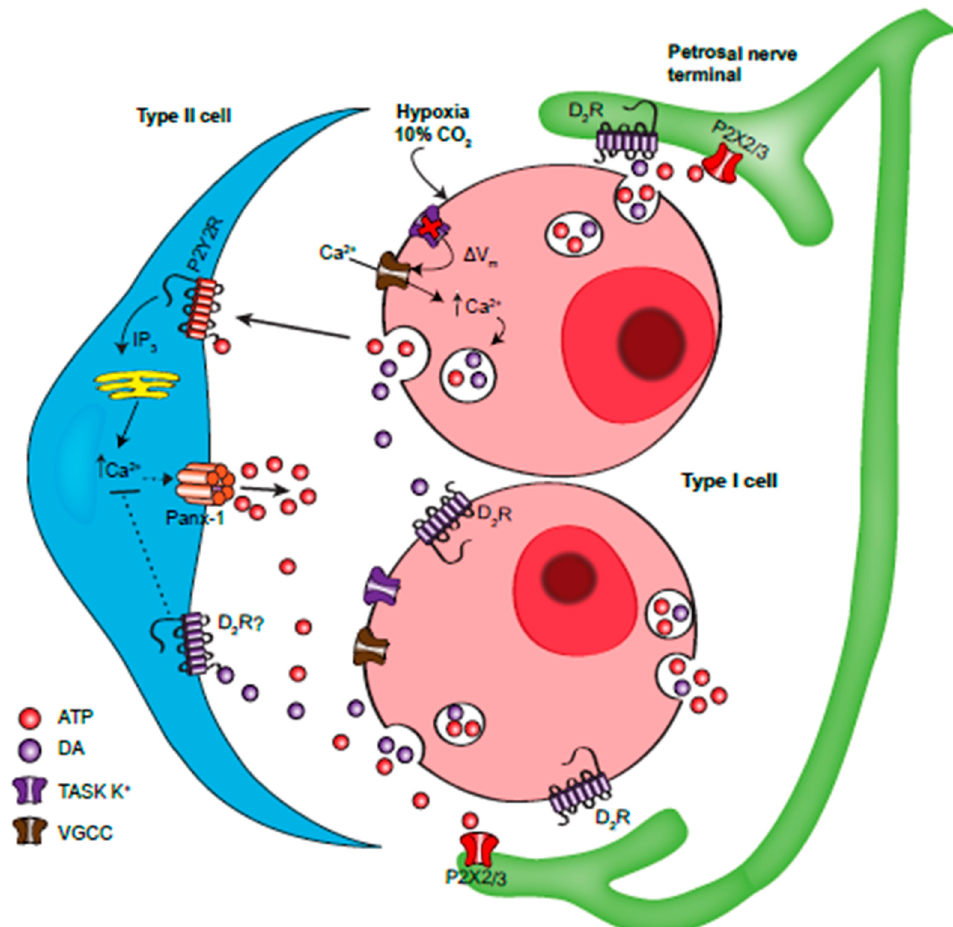
Figure 6. Model of the proposed interactions involving ATP and dopamine at the carotid body ‘tripartite’ synapse. During hypoxia or hypercapnia type I cells depolarize due to inhibition of Two-pore domain, Acid-Sensitive K + (TASK) channels, leading to membrane depolarization, Ca 2 + entry through voltage-gated Ca 2 + channels (VGCC) and vesicular release of ATP and DA. ATP activates postsynaptic P2X2 / 3R on petrosal a ff erent terminals causing excitation. ATP also activates P2Y2R on adjacent type II glial cells, causing a rise in intracellular Ca 2 + via the PLC-IP 3 -Ca 2 + pathway. This leads to Ca 2 + -dependent opening of pannexin (Panx)-1 channels which act as conduits for the release of ATP, thereby contributing directly to petrosal excitation. Co-released DA acts on autocrine-paracrine D2 receptors on the same or adjacent type I cells, leading to a negative feedback inhibition of neurotransmitter release. DA can also act on postsynaptic D2 receptors on petrosal terminals, leading to inhibition of action potential firing. DA may also activate sulpiride-sensitive (D2 and / or D3) receptors on type II cells, leading to a blunting of the ATP-P2Y2R -mediated rise in intracellular Ca 2 + by an unknown mechanism. In this way, DA limits the ability of type II cells to contribute to the synaptic ATP pool via the mechanism of ‘ATP-induced ATP release’ involving Panx-1 channels. Omitted for clarity are paracrine signalling pathways involving other CB neurotransmitters including adenosine, generated in part from the breakdown of extracellular ATP.